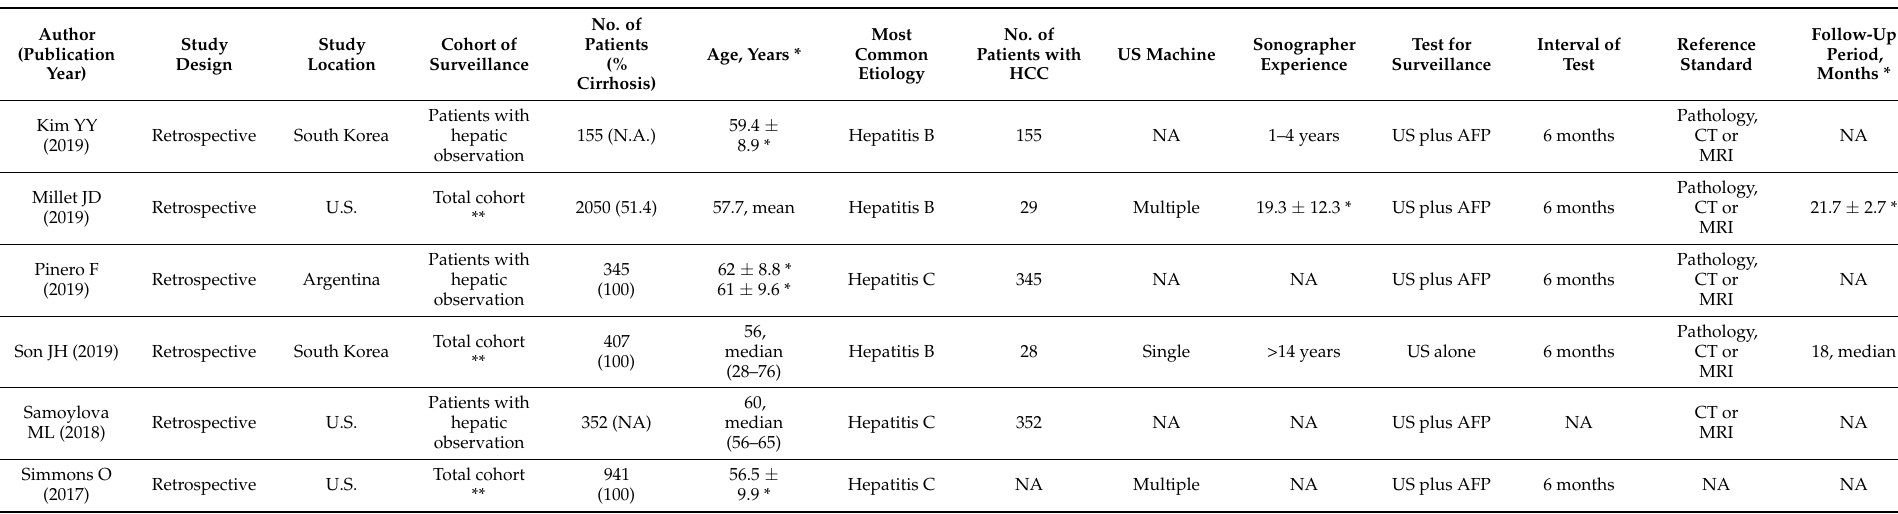
Table 1. Characteristics of the included